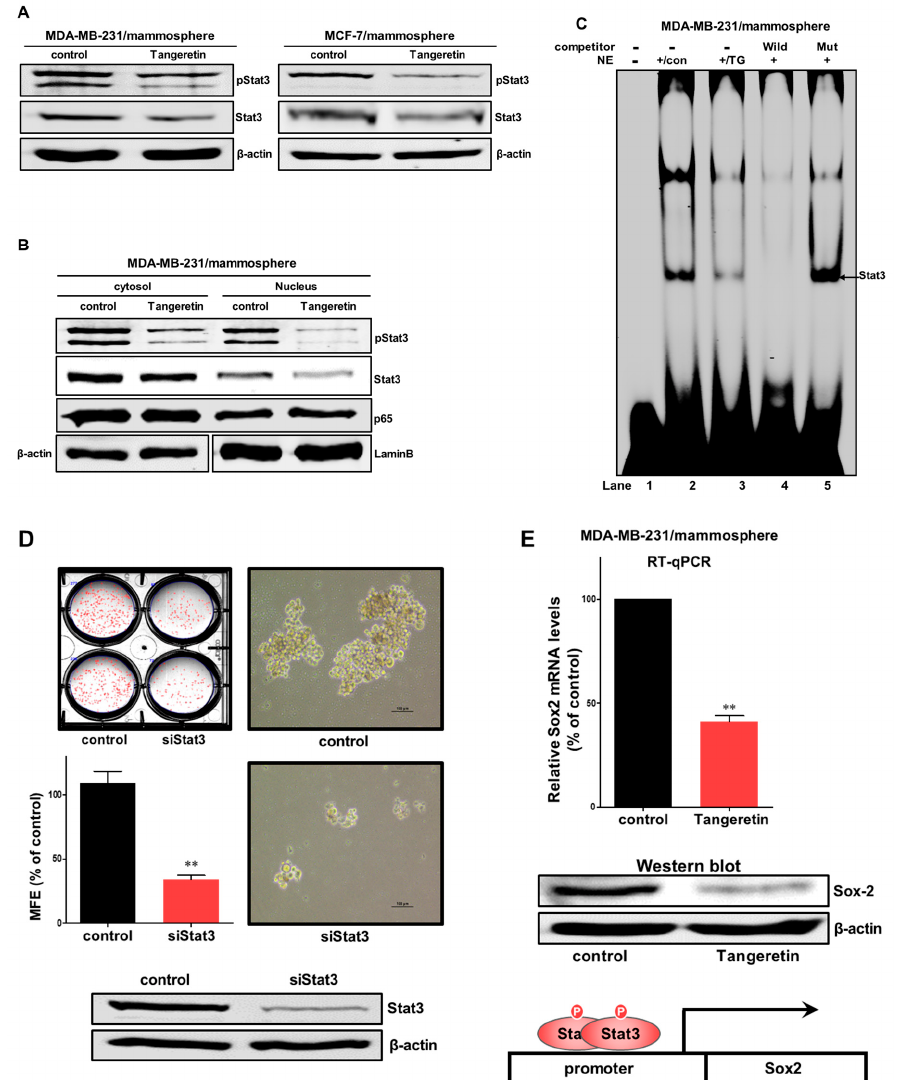
Figure 7. Tangeretin regulates Stat3 signaling and Sox2 regulation. ( A ) The total levels of Stat3 and pStat3 were measured in mammospheres composed of MDA-MB-231 cells and MCF-7 cells after treatment with tangeretin (0 or 60 μ M) for 48 h using western blotting. Total lysates were subjected to immunoblot analysis with anti-Stat3 and anti-pStat3 antibodies. β -actin was used as an internal control. ( B ) The levels of Stat3 and pStat3 in the cytosolic and nuclear protein fractions were measured in mammospheres composed of MDA-MB-231 cells after treatment with tangeretin for 48 h using western blotting. Nuclear and cytosolic proteins were run on SDS-PAGE gels, followed by immunoblotting with anti-Stat3, anti-pStat3, anti- β -actin and anti-Lamin B antibodies. ( C ) EMSA was used to analyze mammosphere nuclear proteins after treatment with tangeretin. Nuclear extracts were reacted with a Stat3 probe and subjected to 6% native PAGE. Lane 1: Stat3 probe; lane 2: nuclear extracts with the Stat3 probe; lane 3: tangeretin-treated nuclear proteins with the Stat3 probe; lane 4: nuclear proteins incubated with a self-competitor oligo (100 × ); and lane 5: nuclear extracts incubated with a mutated-stat3 probe (100 × ). The arrow indicates the DNA / Stat3 complex in the mammosphere nuclear lysates. ( D ) E ff ect of Stat3 on mammosphere formation using siRNA of Stat3. Stat3-downregulated MDA-MB-231 cells were cultured for seven days using mammosphere media. Images were obtained by microscrope at 100 × magnification. ( E ) The transcriptional level of the Sox2 gene in MDA-MB-231 was determined in tangeretin-treated mammospheres. A Sox2-specific primer was used for real-time RT-qPCR. Western blot analysis of mammosphere under tangeretin. β -actin served as an internal control. The data are presented as the mean ± SD of three independent experiments. ** p < 0.01 versus the DMSO-treated control